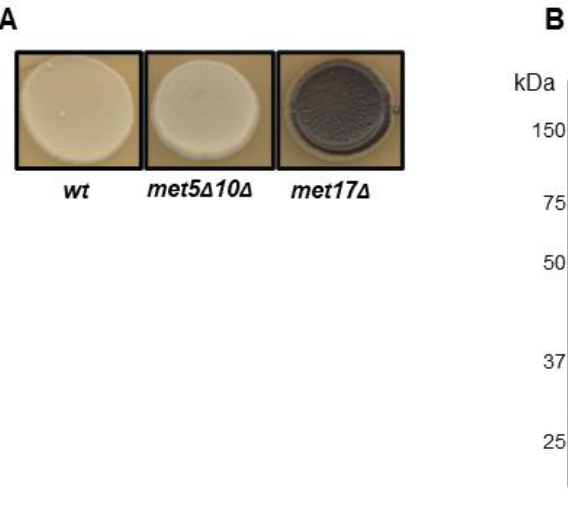
Figure 1. H 2 S productivity correlates with S-persulfidated protein levels. ( A ) H 2 S productivity by wt , met5 ∆ met10 ∆ , and met17 ∆ . Cells were incubated at 30 ◦ C on YPDL plates for 4 days. ( B ) S-persulfidated proteins in wt , met5 ∆ met10 ∆ , and met17 ∆ strains. Whole-cell extracts from exponential- phase cultures were subjected to the modified biotin switch assay with antibody against biotin ( α -Biotin Ab) in order to detect S-persulfidation.